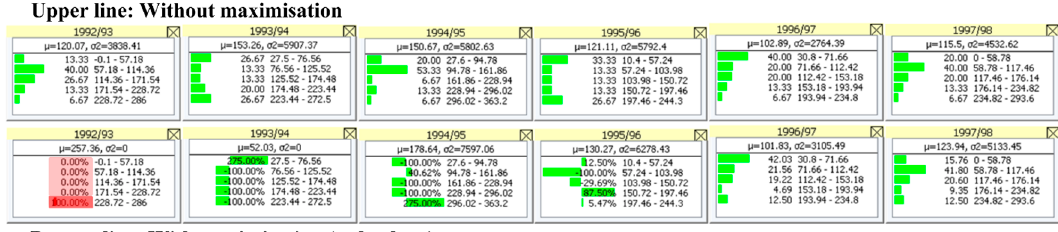
Figure 6. Output of BNs Simulation for the Adaja sub ‐ basin (Max 1992/1993 year). Results expressed as relative percentage of change (dynamic and causal dependence) in intervals. Software: HUGIN Expert (V 7.3) [61].